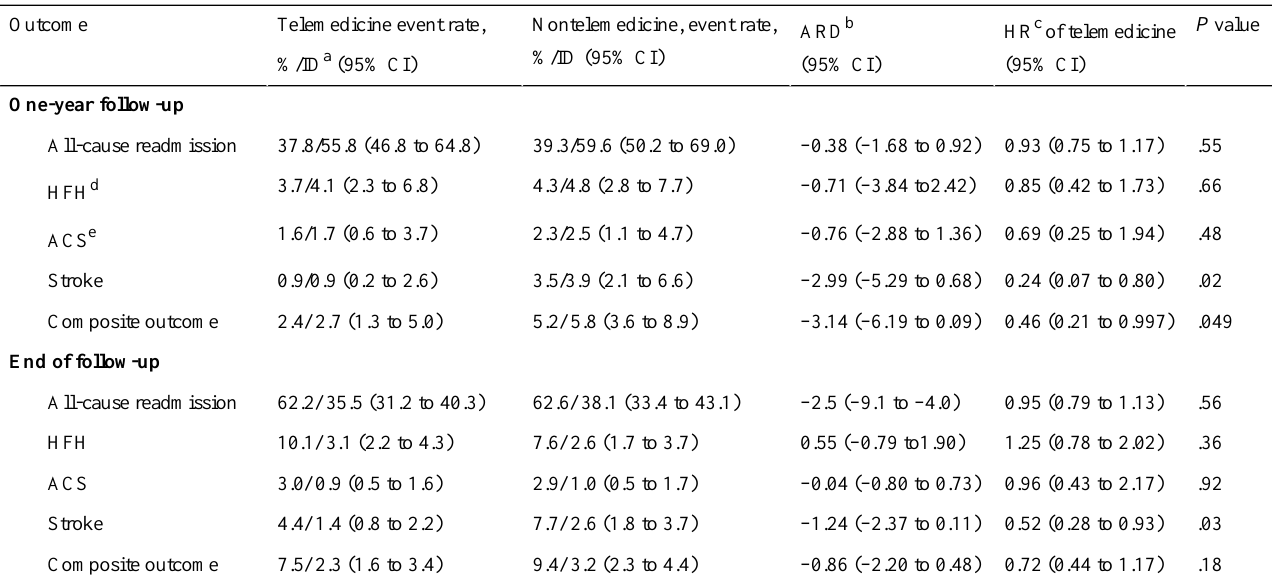
Table 2. Follow-up outcomes (after inverse probability treatment weighting) in patients with peripheral arterial occlusive disease who participated (n=162) and did not participate (n=229) in the telemedicine